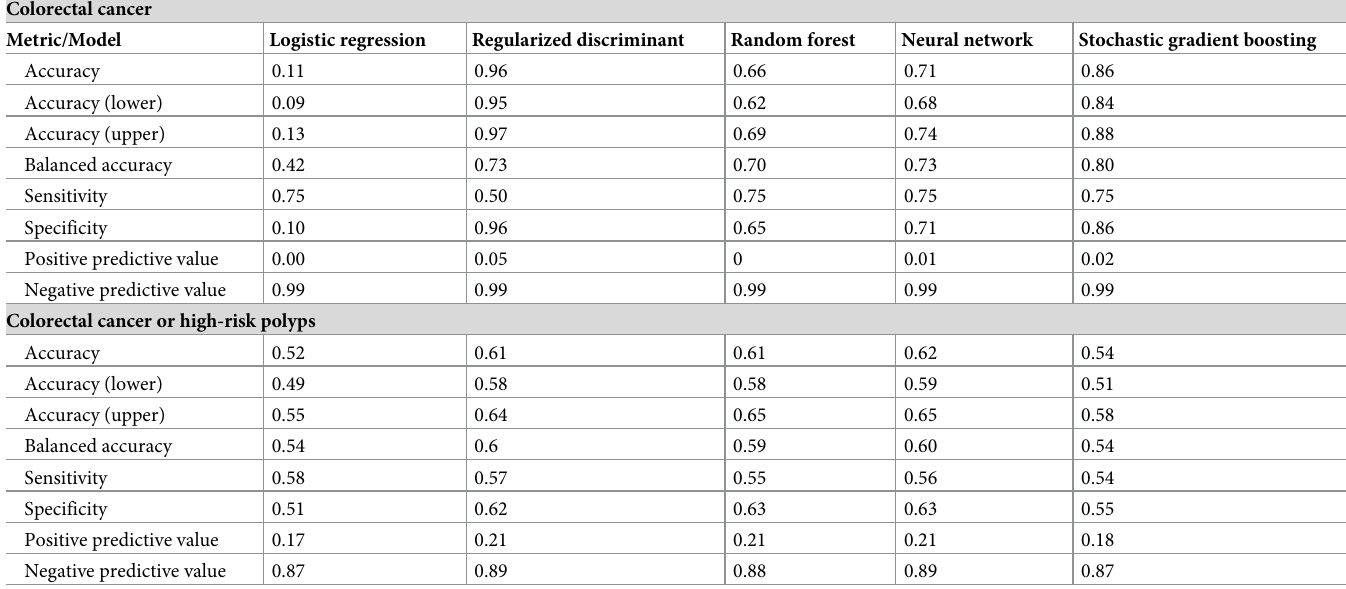
Table 2. Performance metrics of different prediction